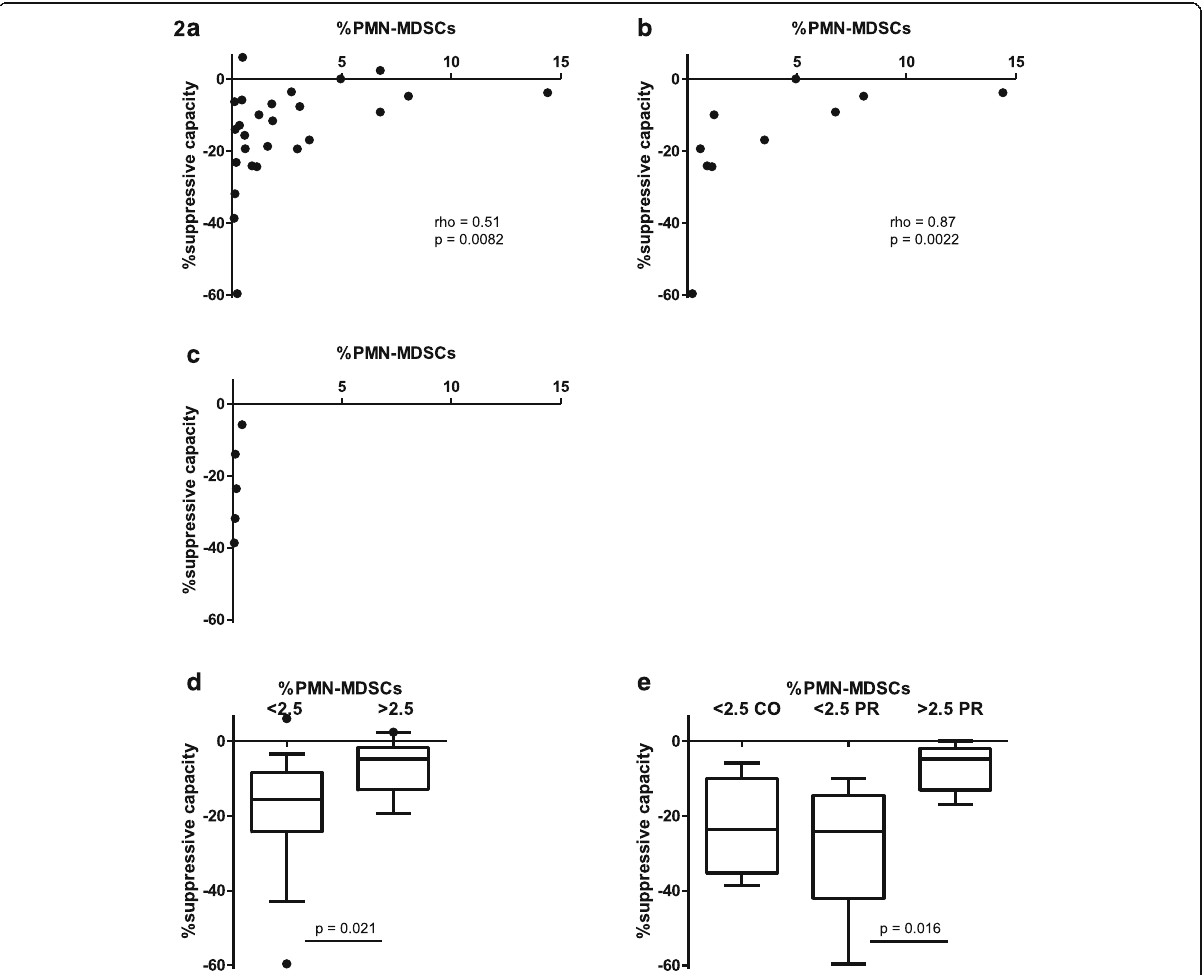
Fig. 2 Suppressive capacity of PMN-MDSCs and correlation with PMN-MDSC frequencies. ( a + b + c ) The suppressive capacity of PMN-MDSCs correlates inversely and significantly with the PMN-MDSC frequencies in all subjects (rho = 0.51, p = 0.0082) ( a ) and in progressors (PR) (rho = 0.87, p = 0.0022) ( b ), whereas there is no significant correlation in controllers (CO) (rho = 0.90, p = 0.083) ( c ). ( d + e ) The suppressive capacity is significantly lower in subjects with PMN-MDSC frequencies above 2.5% compared to subjects with frequencies below 2.5% in all subjects ( p = 0.021) ( d ) and in PR subjects ( p = 0.016) ( e ). All controllers have PMN-MDSC frequencies below 2.5% ( e ). [all subjects: n = 26; PR: n = 10; CO: n = 5; HC: n = 5; BRO: n =